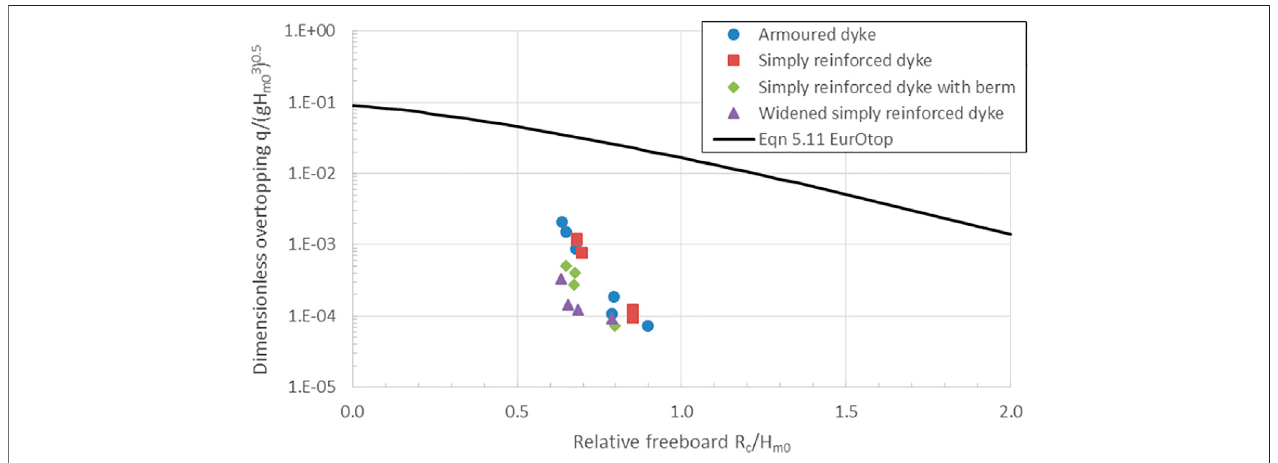
FIGURE 16 | Wave overtopping at four different dyke structures with identical marsh